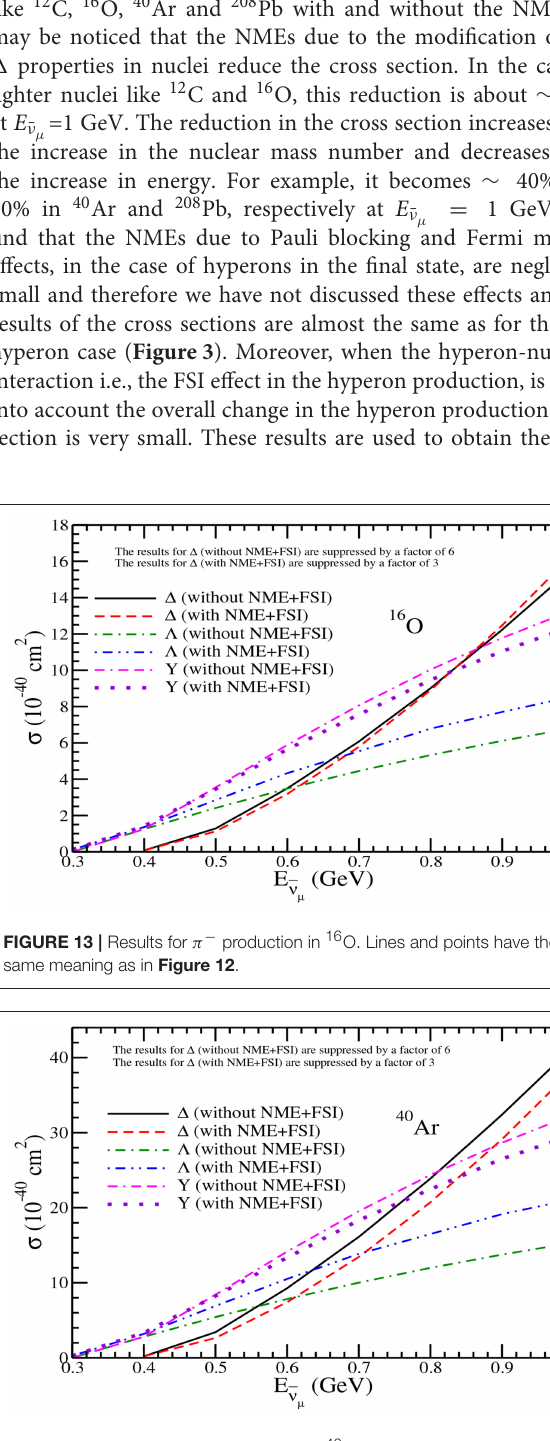
Frontiers in Physics |